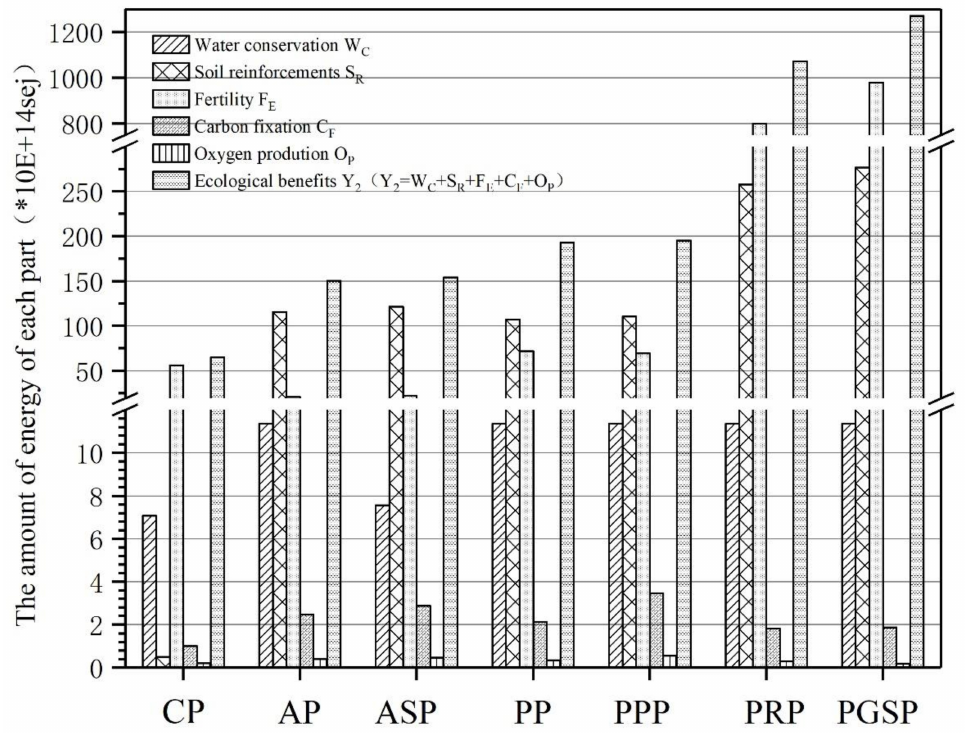
Figure 3. Ecological benefits of the seven typical agroforestry planting